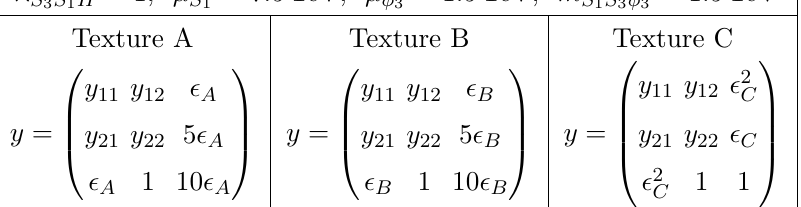
Table 1 . The parameters (cid:21) S , (cid:22) S , (cid:22) (cid:30) and m S have been (cid:12)xed to the values indicated. 3 S 1 H 1 3 1 S 3 (cid:30) 3 Three di(cid:11)erent leptoquark coupling matrix textures were used to scan the parameter space, each matrix texture having (cid:12)ve of the nine leptoquark couplings (cid:12)xed, as above, while the other four leptoquark couplings, speci(cid:12)cally y 11 , y 12 , y 21 and y 22 , are scanned over. In texture A, (cid:15) A = 10 (cid:0) 5 , in texture B, (cid:15) B = 10 (cid:0) 3 , and in texture C, (cid:15) C = 10 (cid:0) 1